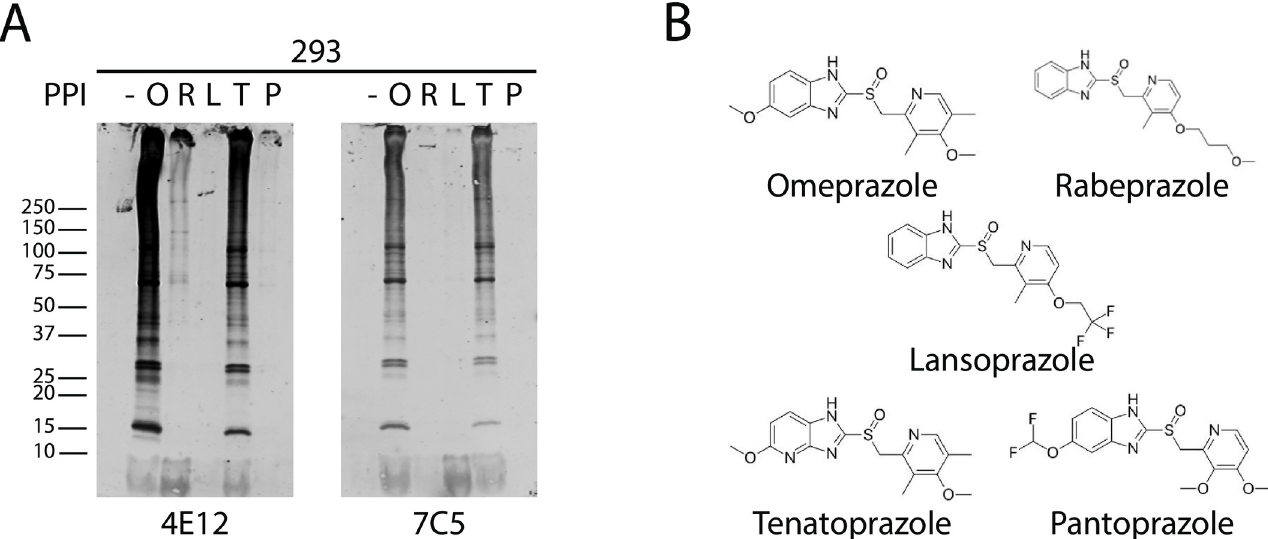
Fig 6. Formation of PPI-protein complexes involving tenatoprazole and rabeprazole. (A) HEK293 cell lysates treated with different PPIs, (O = Omeprazole, R = Rabeprazole, L = Lansoprazole, T = Tenatoprazole, P = Pantoprazole) 1mM at 37˚C for 2 hours, shows the formation of PPI-protein complexes which were recognized by the omeprazole antibody. Tenatoprazole cross reacted the most with omeprazole antibody, followed by rabeprazole. Samples contain no reducing agent and boiled for 3 minutes. (B) A comparison of PPI structures show structural similarities of compounds tested in (A) to omeprazole.